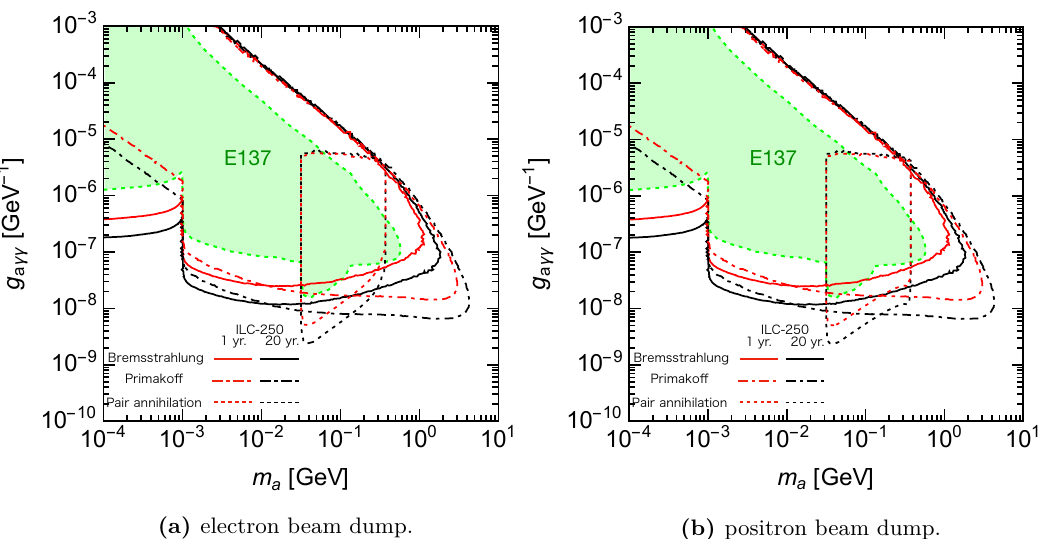
Figure 5. The same plot as figure 4 but in the ( m a , g aγγ )